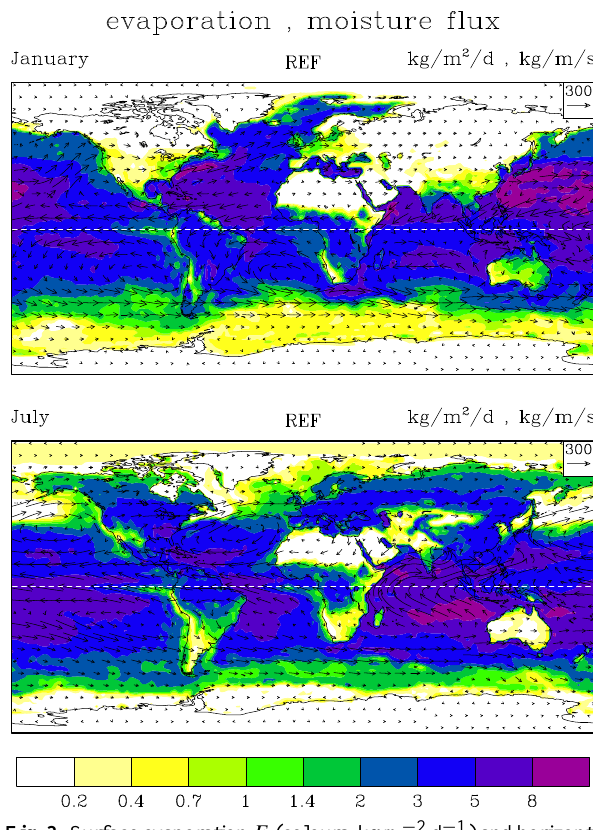
Fig. 2. Continental recycling ratio R c (% continental moisture in precipitation) in the REF experiment.